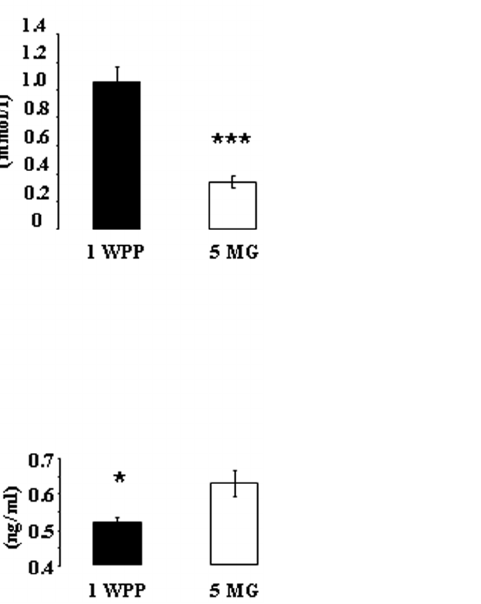
Figure 2. Plasma resistin, NEFA, glucose and insulin levels at 1 week post partum (WPP 1) and 5 months of gestation (5 MG) during the second lactation. Plasma resistin, NEFA, glucose and insulin concentrations measured on the day of adipose tissue biopsy (1 WPP and 5 MG) in Holstein dairy cows. Animals ( n =8 in each group) were fasted for 12 hours before surgery Results are presented as means 6 SEM. Results are considered significantly different if p , 0.05. * and *** indicate significant differences at p , 0.05 and p , 0.0001,